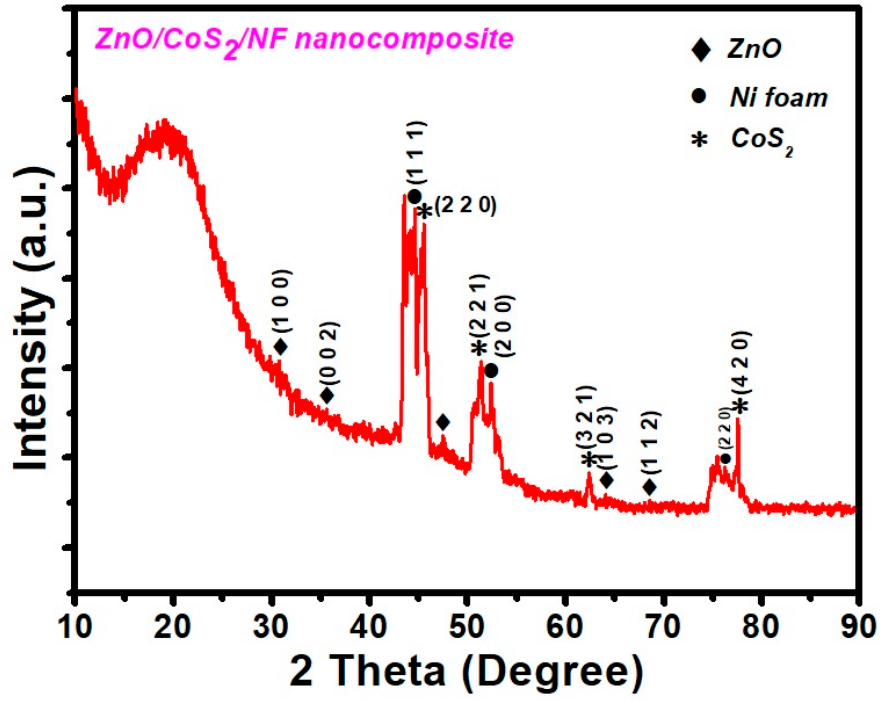
Figure 1. XRD pattern of ZnO/CoS 2 /NF nanocomposite.